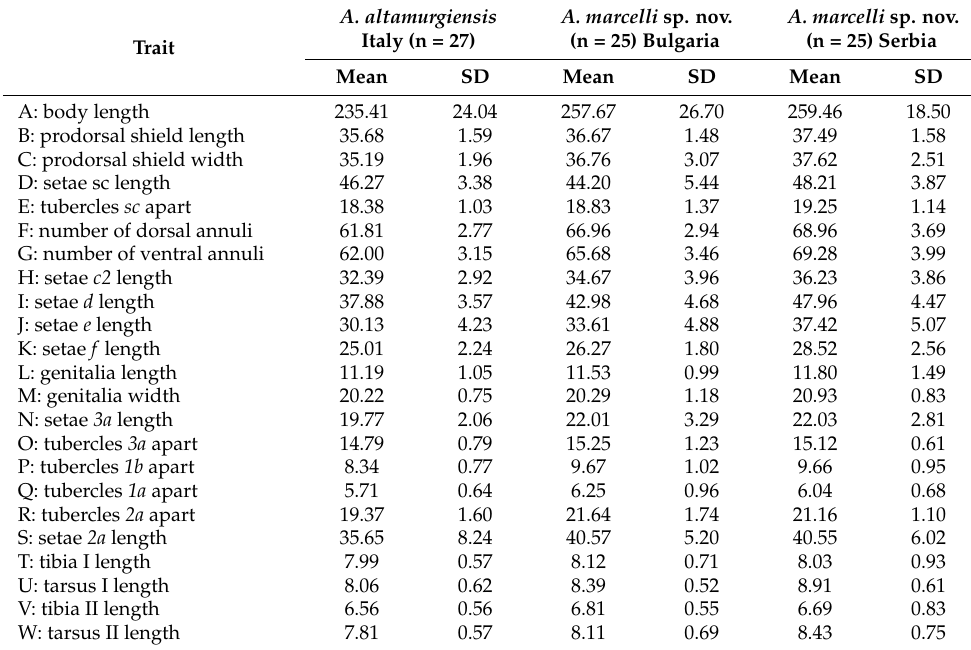
Table 1. Means and standard deviations (SD) for 23 morphological traits of Aculodes altamurgiensis from Taeniatherum caput-medusae collected in Italy and Aculodes marcelli sp. nov., from Anisantha tectorum collected in Bulgaria and Serbia (n = number of